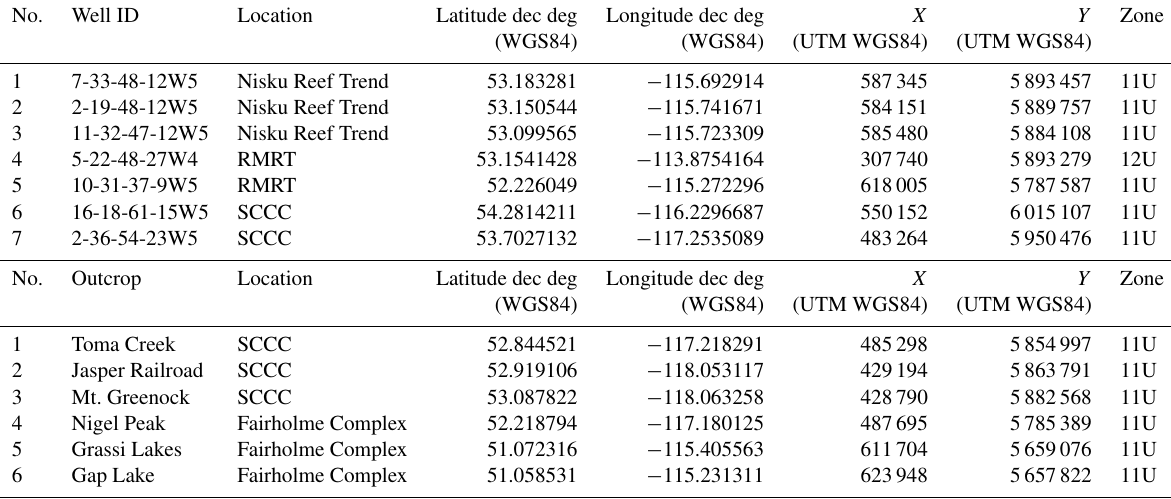
Table B1. Coordinates of the well locations and outcrops in the Front